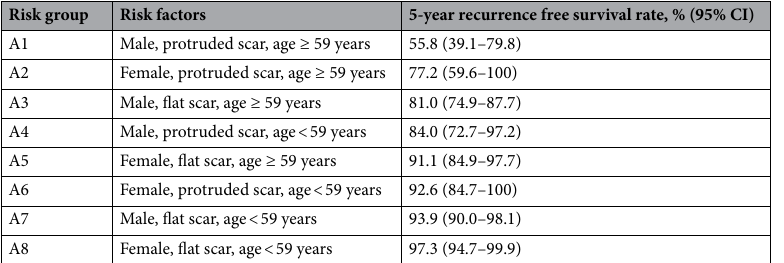
Table 3. Risk groups categorization according to the associated risk factor for recurrence after endoscopic submucosal dissection with curative resection gastric adenoma and five-year recurrence free survival rate. CI, confidence